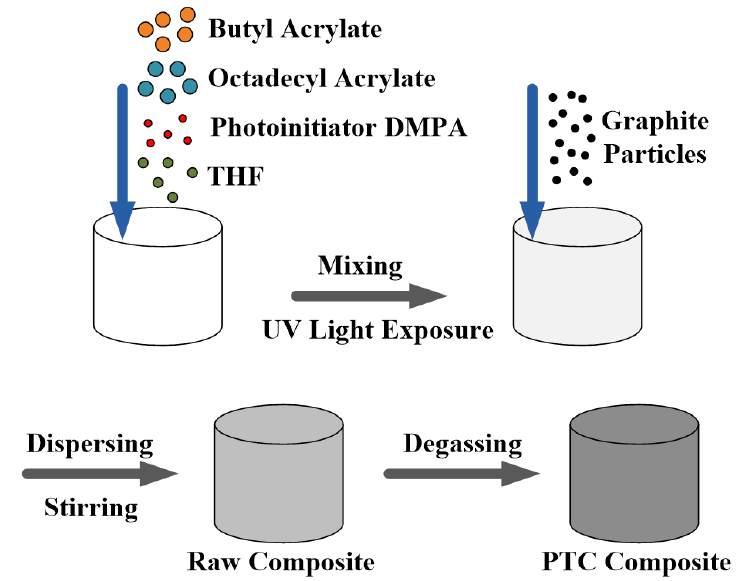
Figure 2. Preparation of the PTC composite.